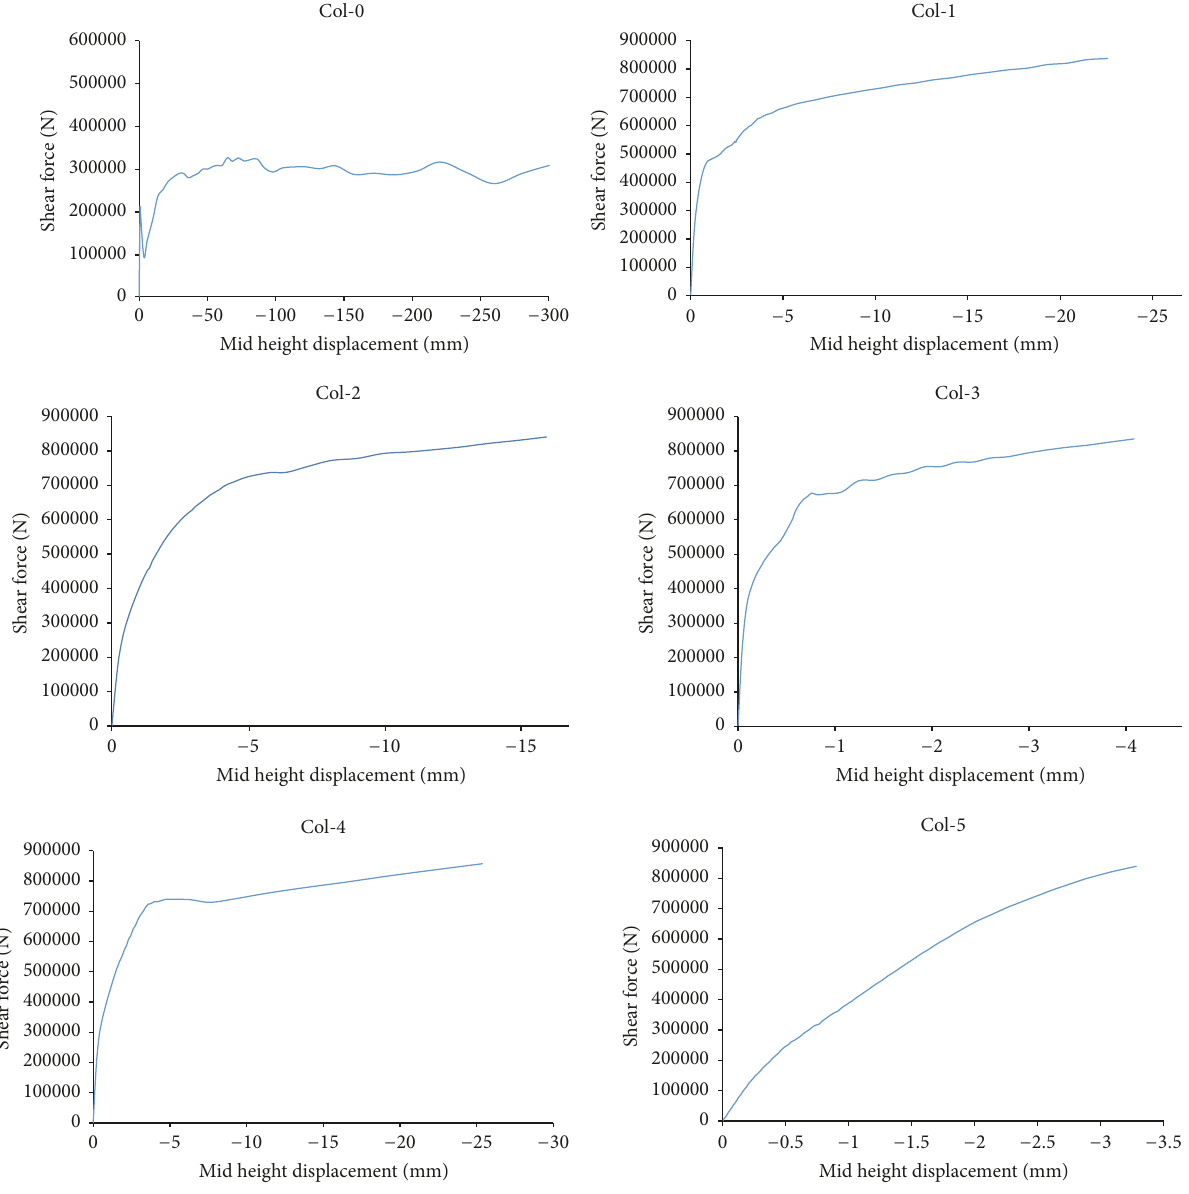
Figure 13: Results of shear strength of